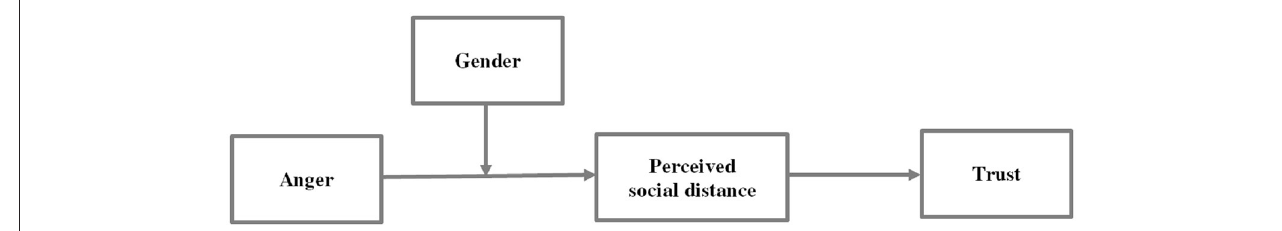
FIGURE 1 | Conceptual moderated mediation